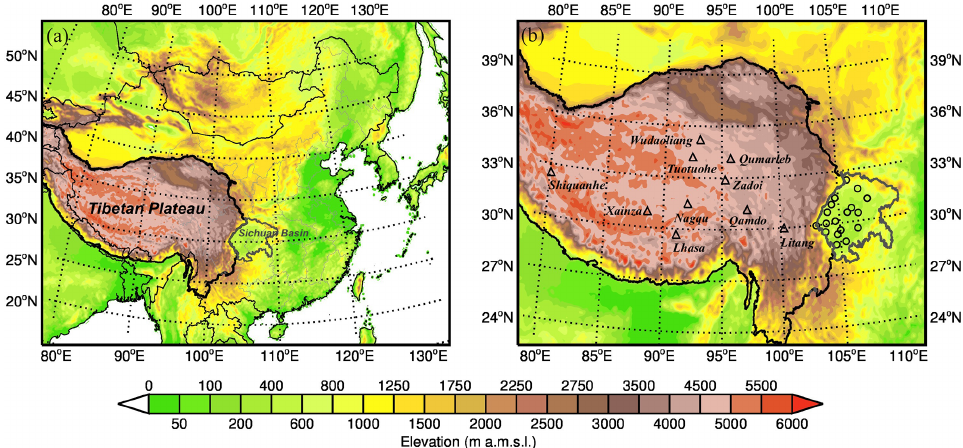
Figure 1. (a) Location map of the Tibetan Plateau (the region surrounded by the dark line) and the Sichuan Basin (the region surrounded by the gray line). (b) The model domain and the distribution of weather stations are marked as the triangles over the Tibetan Plateau, and air quality stations are marked as the circles over the Sichuan